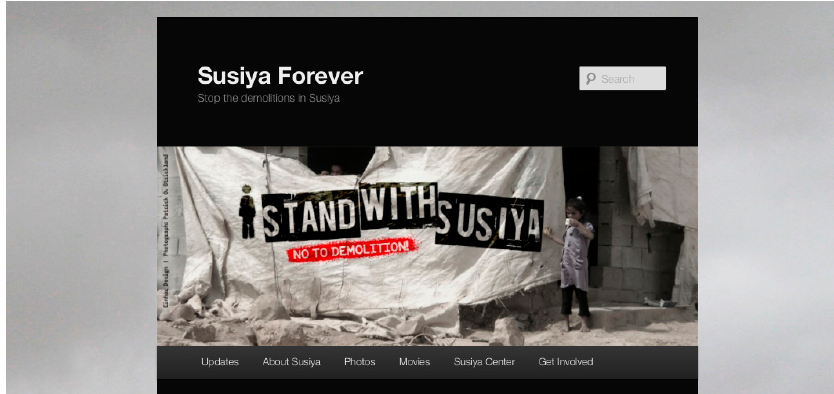
Figure 1. Screen grab of the Susiya Forever WordPress home page (Accessed on 15 October 2016).